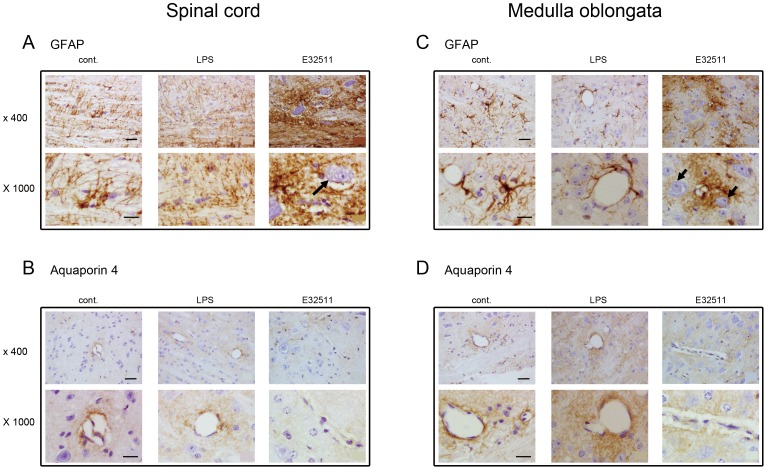
AST activation and AQP4 expression in E32511 model and i.p. LPS-injected mice.(A) Severe diffuse astrogliosis was observed in spinal cord of E32511-infected but not in control and LPS-injected mice at low (400×) and high (1000×) magnifications. The black arrow shows a degenerating neuron adjacent to an activated astrocyte. (B) More intense staining of AQP4 was observed surrounding the ECs which comprised the BBB in the spinal cord in control and LPS-injected mice, but not in E32511-infected mice at low (400×) and high (1000×) magnifications. (C) Severe diffuse astrogliosis was observed in the medulla oblongata of E32511-infected but not in control and LPS-injected mice at low (400×) and high (1000×) magnification. The black arrow shows a degenerating neuron adjacent to an activated astrocyte. (D) More intense staining of AQP4 was observed surrounding the blood vessels that comprise the BBB in the medulla oblongata in control and LPS-injected mice, but not in E32511-infected mice at low (400×) and high (1000×) magnifications. Scale bars (400×): 2 µm and (1000×): 1 µm.